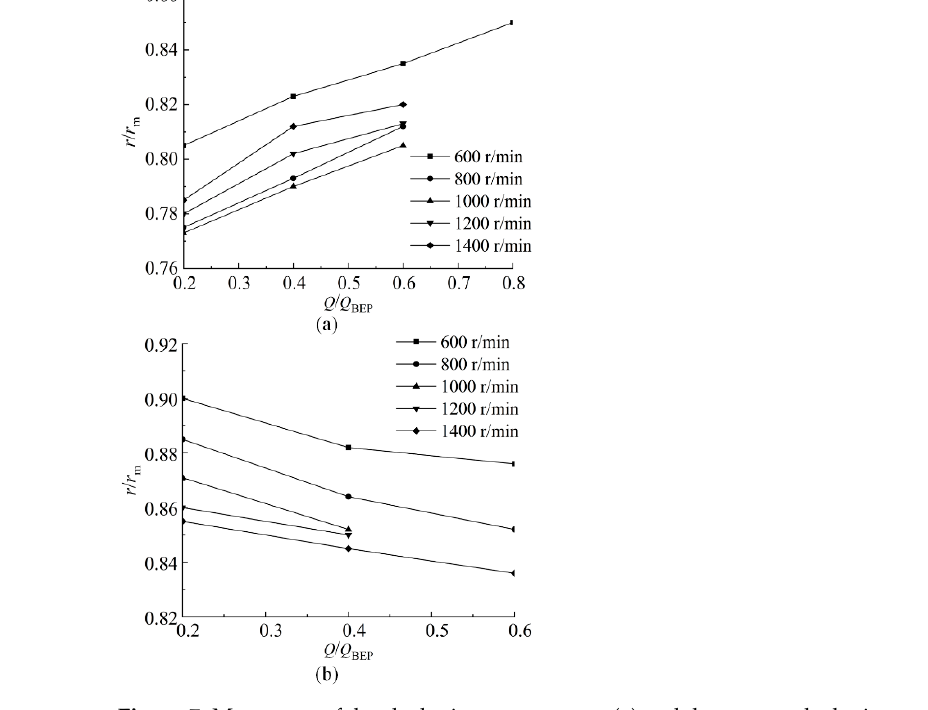
Figure 7. Movement of the clockwise vortex center ( a ) and the counterclockwise vortex ( b ) at differ- ent rotational